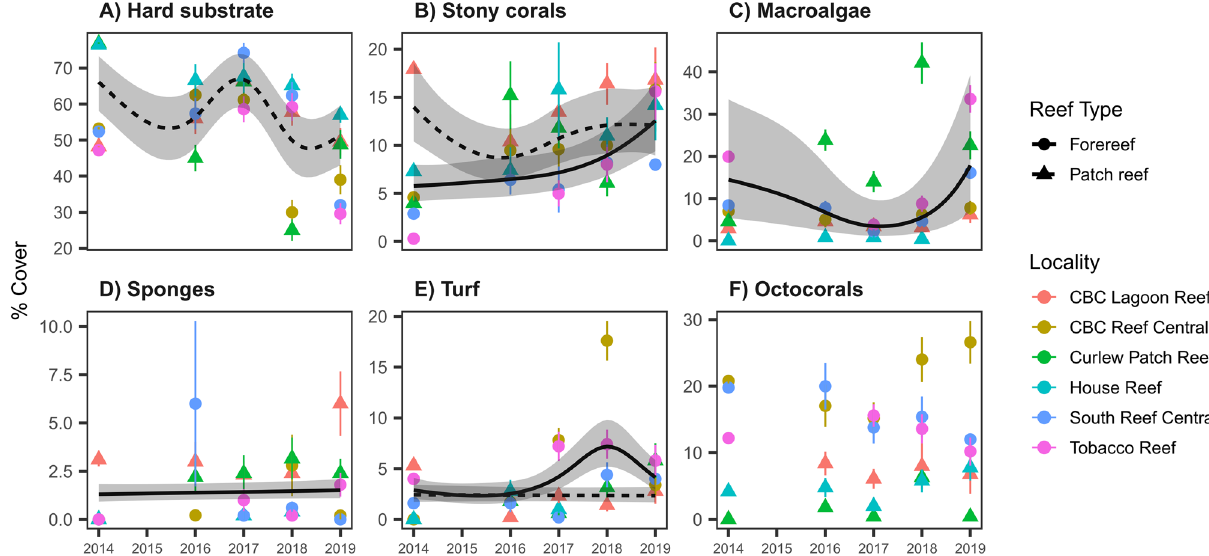
Figure 3. Mean percent cover for each of the five main benthic functional groups and consolidated (hard) substrate. Points are means ± 1 standard error for each of the 6 localities. Lines are fitted predictions from a generalized additive model ± 95% confidence intervals for only those reef types with significant ( P < 0.05) changes in cover through time, with solid lines denoting significant trends on patch reefs and dashed lines on